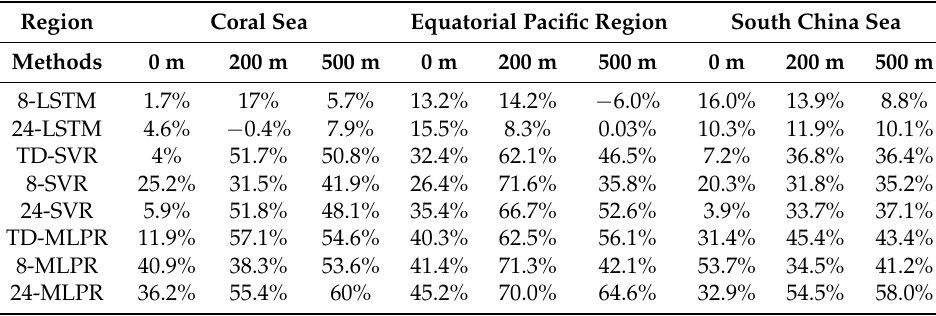
Figure 10. Comparison of performances at different depth in the South China Sea. Table 2. Comparison of TD-LSTM performance improvement